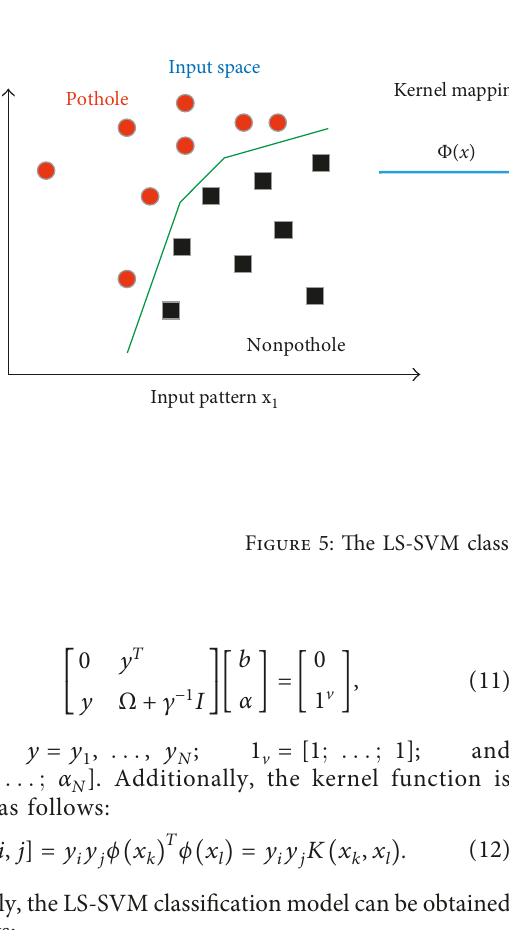
Figure 4: The ANN model structure used for pothole detection.